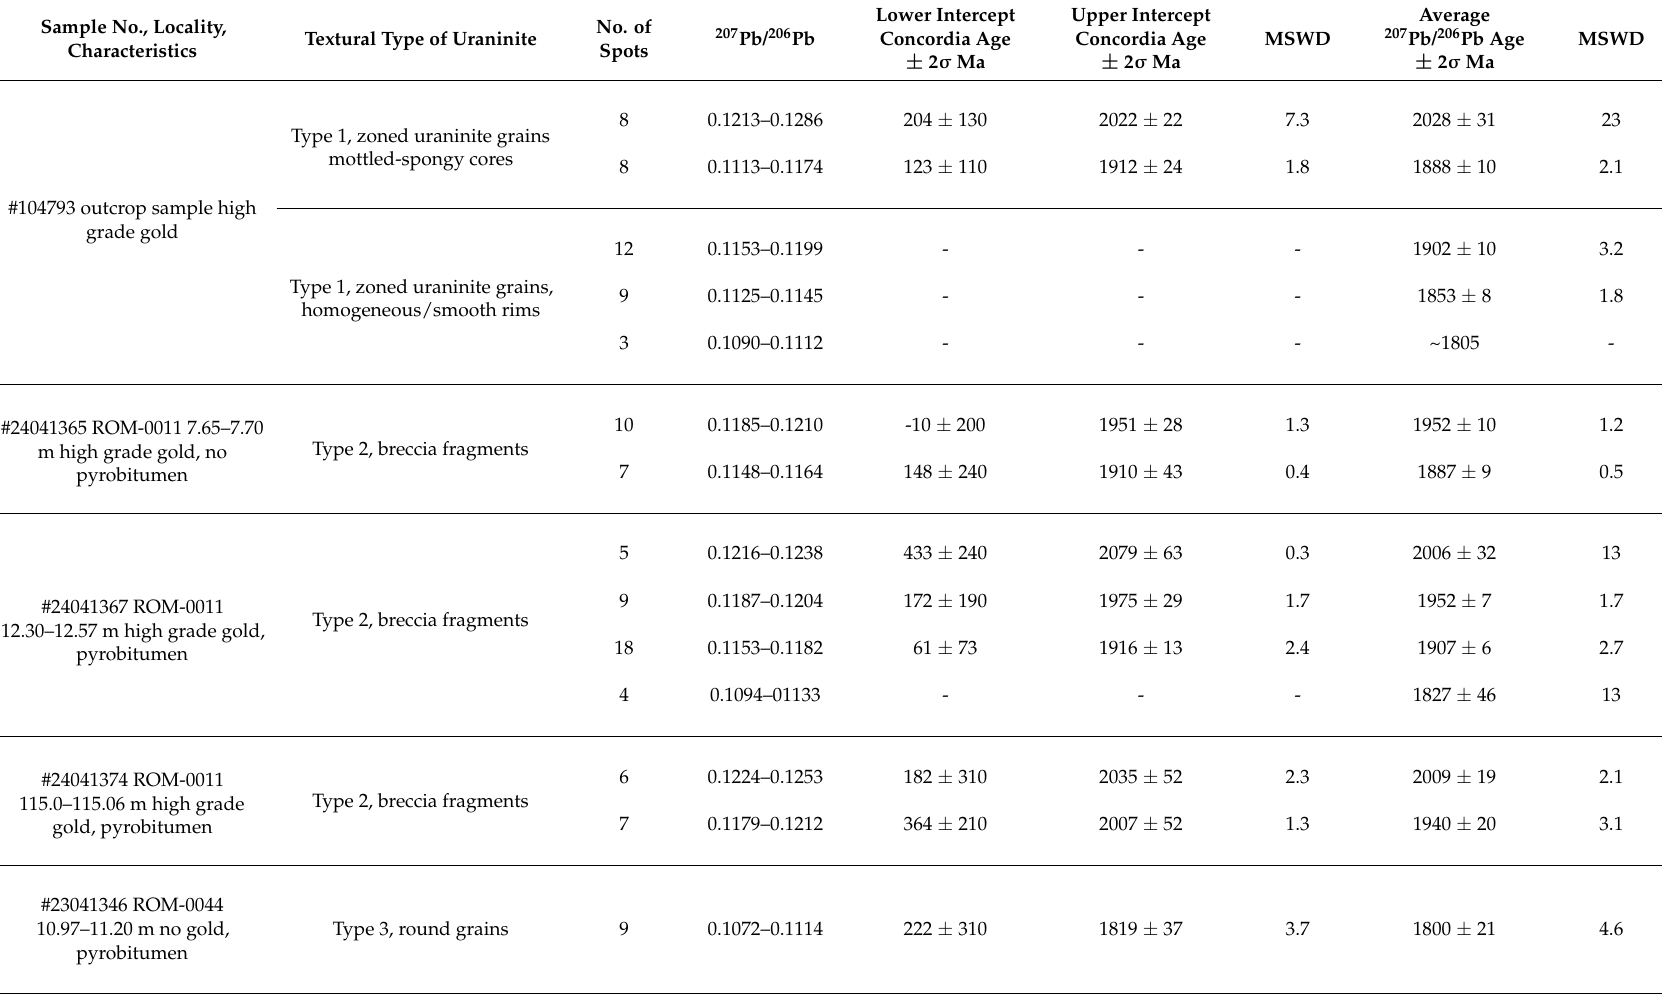
Table 1. Summary of the results of the U–Pb dating of uraninite from the Rompas